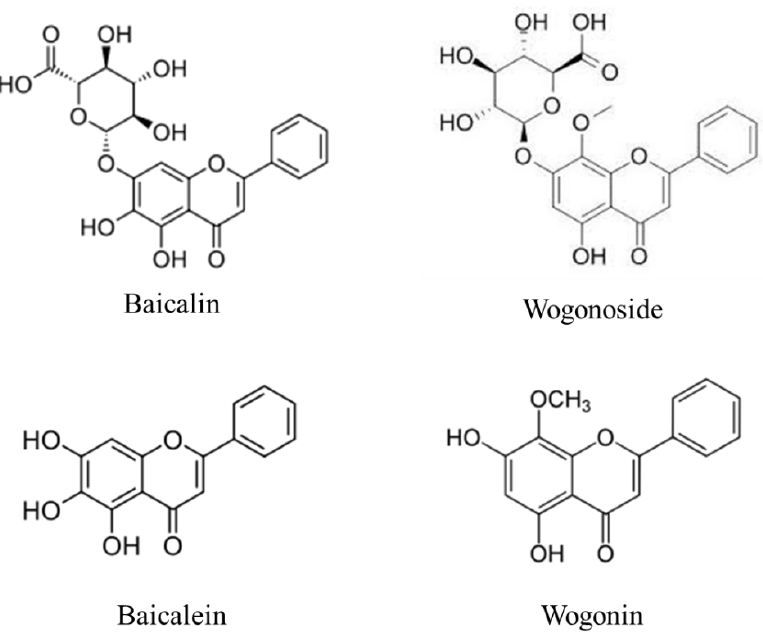
Figure 1. Chemical structures of baicalin, wogonoside, baicalein and wogonin.